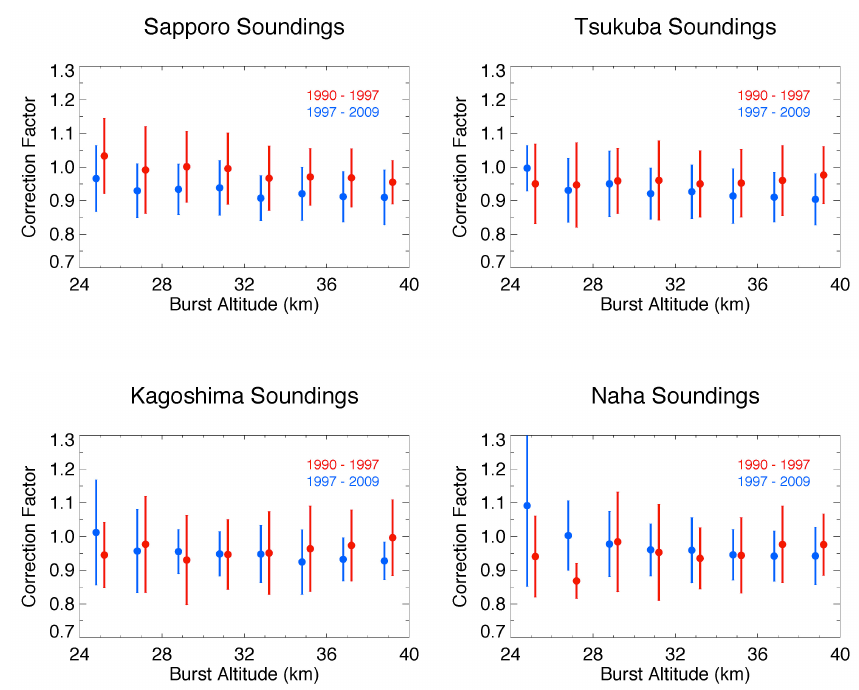
Fig. 3b. As in Fig. 3a, but the CFs are calculated on columns computed using the balloon burst climatology to compute the above-burst altitude Figure 3b. As in Figure 3a, but the CFs are calculated on columns computed using the 977 balloon burst climatology to compute the above-burst altitude columns. 978